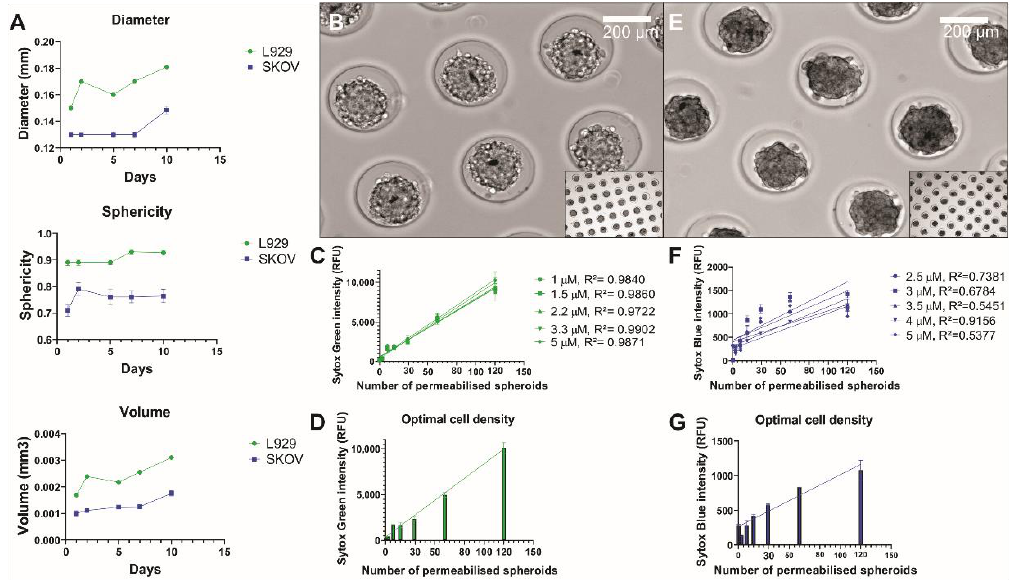
Figure 2. Characterization of the spheroids and analysis of linear correlation between Sytox intensity and cell density. ( A ) Diameter, sphericity and volume of L929 and SKOV spheroids. ( B ) Brightfield image of day 1 L929 spheroids showing globular spheroids that are not yet fully compacted. ( C ) Sytox Green intensity for di ff erent concentrations of Sytox Green was plotted out against di ff erent spheroid densities. Linear correlation was measured as R 2 and the highest correlation was found for Sytox Green 3.3 µ M. ( D ) The increase of Sytox intensity for Sytox Green 3.3 µ M is shown. Starting from 30 spheroids, a high increase in intensity was found until 120 spheroids. ( E ) Brightfield image of day 1 SKOV spheroids showing irregularly shaped spheroids that are quite compact. ( F ) Sytox Blue intensity for di ff erent concentrations of Sytox Blue was plotted out against di ff erent spheroid densities. Linear correlation was measured as R 2 and the highest correlation was found for Sytox Blue 4 µ M. ( G ) The increase of Sytox intensity for Sytox Blue 4 µ M is shown. Starting from 30 spheroids, a high increase in intensity was found until 120 spheroids.